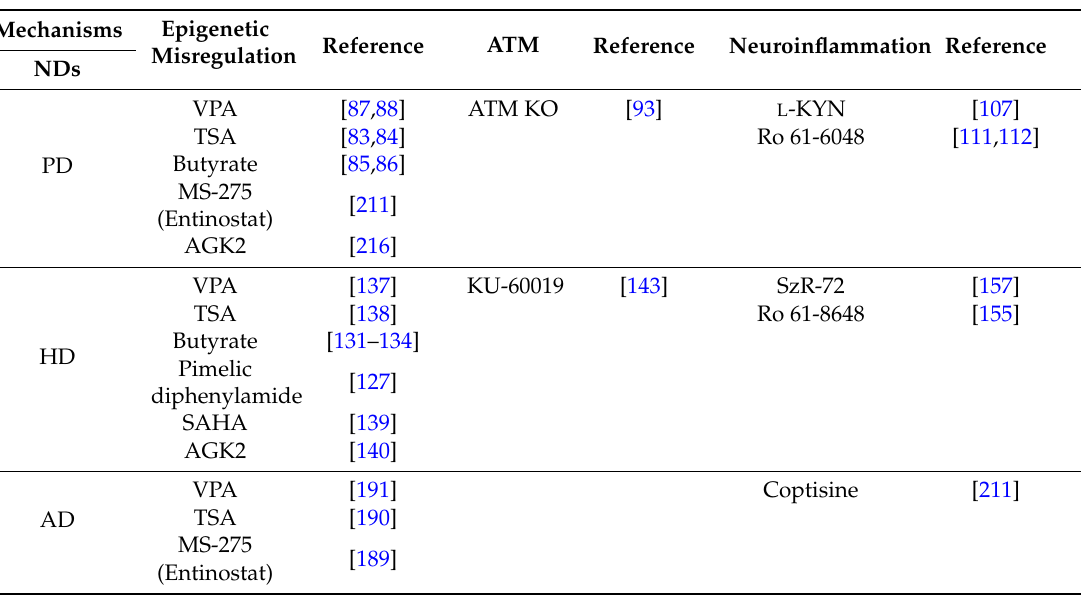
Table 1. Potential drugs or interventions for the treatment of neurodegenerative diseases (NDs), including Parkinson’s disease (PD), Huntington’s disease (HD), and Alzheimer’s disease (AD), are classified by mechanisms, including epigenetic misregulation, ATM, and